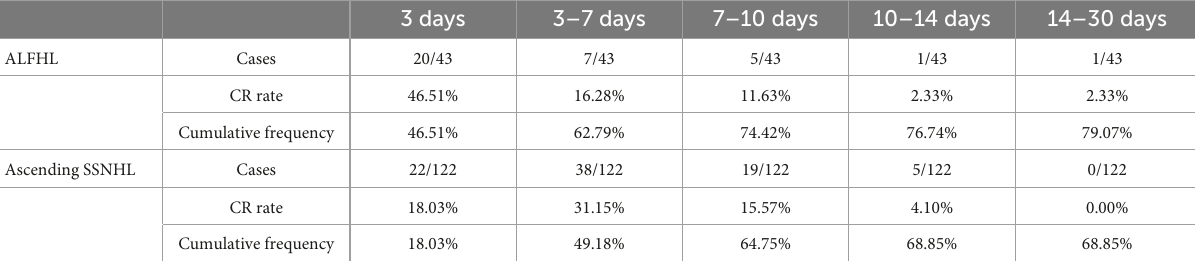
TABLE 4 Distribution of onset-CR of patients with ascending sudden sensorineural hearing loss (SSNHL) and acute low-frequency hearing loss